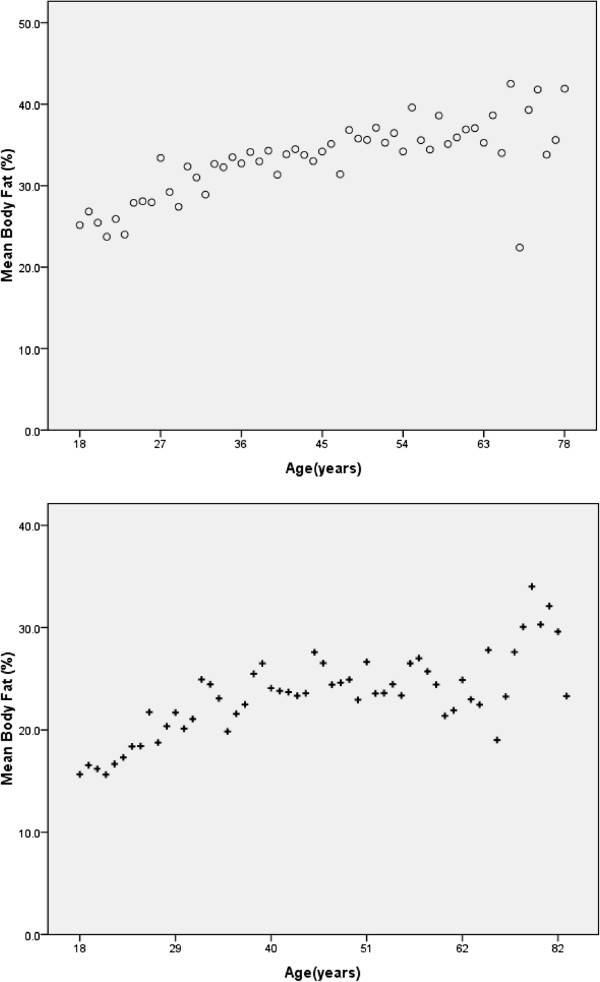
Relationship between percent body fat (BF%) and age in (o)females (upper graph) and (+)males (lower graph).